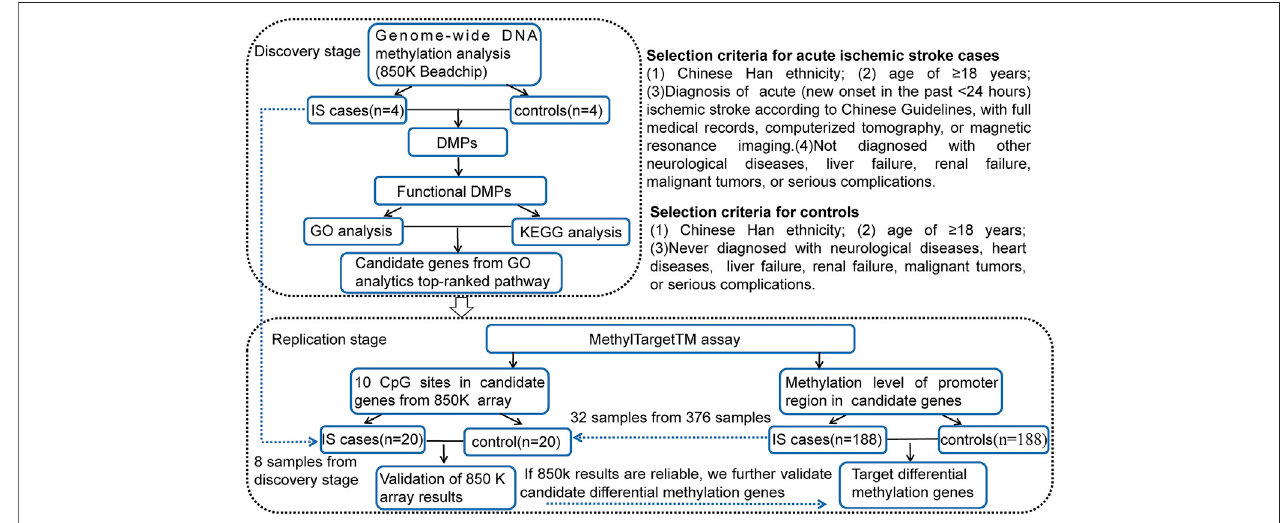
FIGURE 1 | Two-stage case-control study design and selection criteria for cases and controls. IS, ischemic stroke; DMPs, DNA methylation positions; GO, gene ontology; KEGG, Kyoto Encyclopedia of Genes and Genomes; CpG, cytosine phosphate guanine.